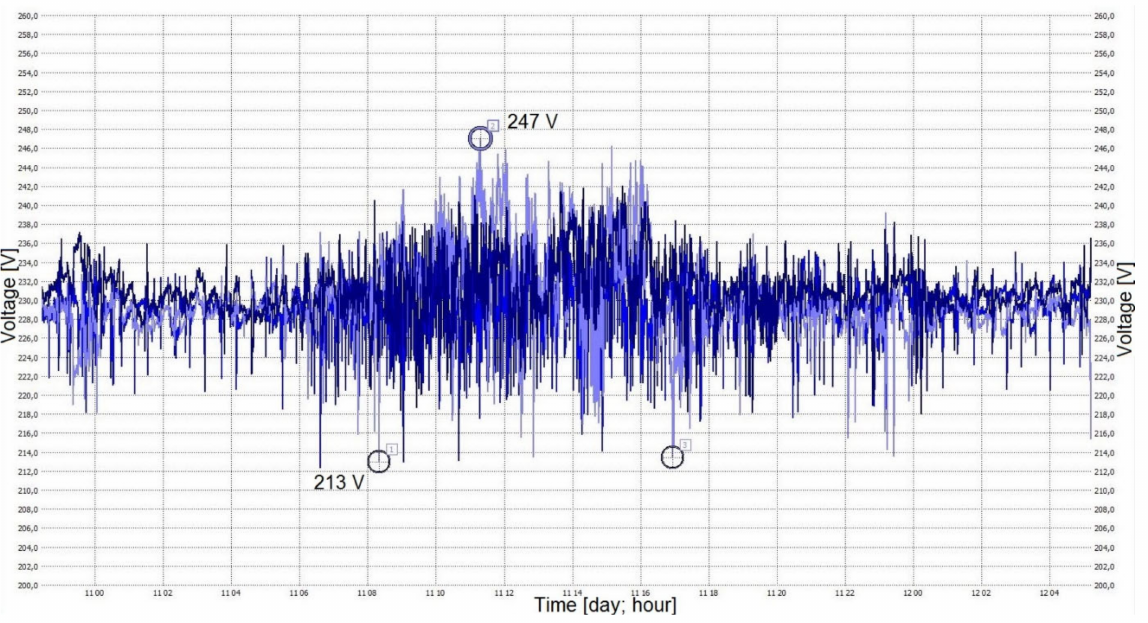
Figure 8. Voltage variations V C in node 114 (period: 11 June 2021, hour 0:00 a.m. − 12 June 2021, hour 4:00